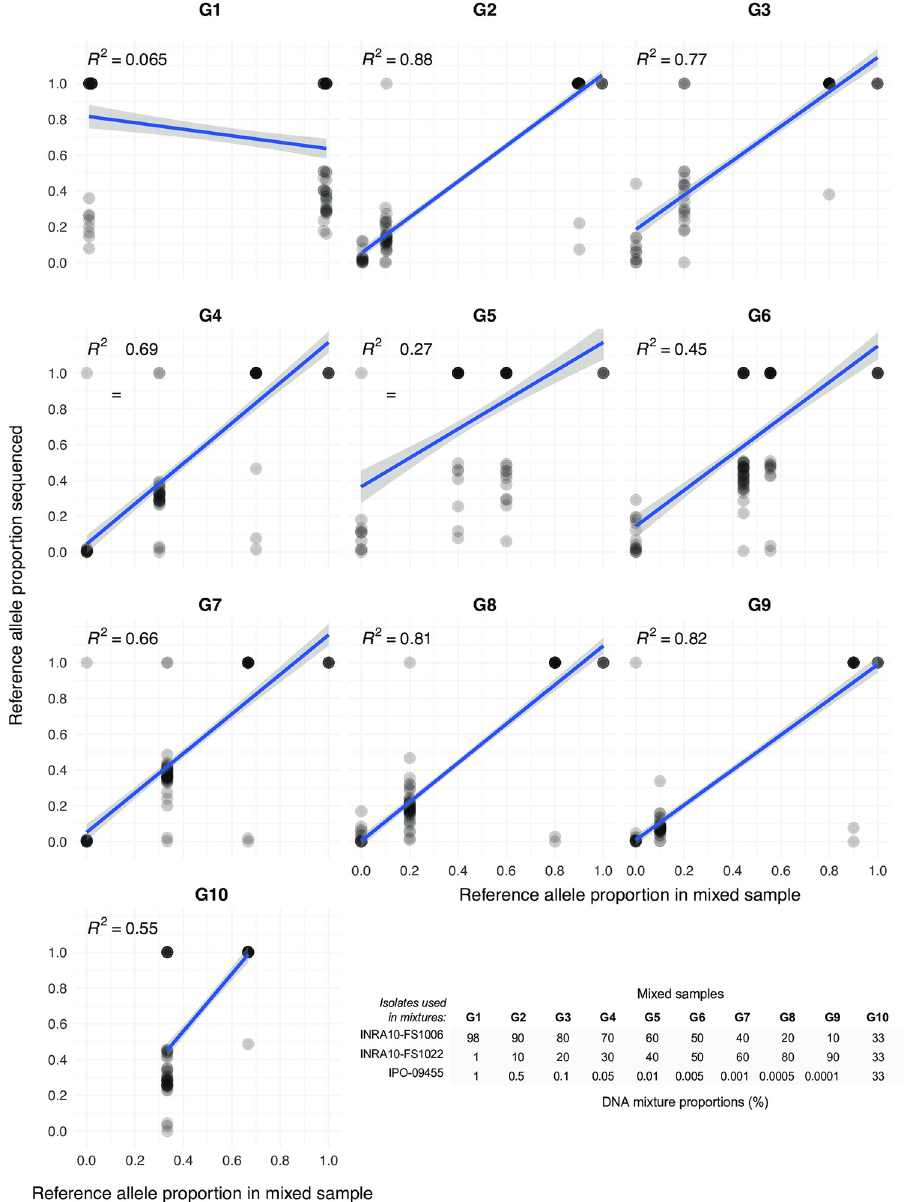
Fig 4. Evaluation of mixed sample analyses. Ten samples (G1-G10) contained mixed DNA of three different isolates (INRA10-FS1006, INRA10-FS1022, IPO-09455) varying in proportions. Genotypes of each of the isolates were retrieved from whole-genome sequencing of pure isolates and assigned as reference alleles ( i . e . matching the allele present in the reference genome IPO323) or alternative alleles. Using known genotypes of the three isolates, reference allele proportions were defined according to the dilutions in mixed samples G1-G10. Amplicon sequencing data of mixed samples was screened for all genotyped SNPs to assess the proportion of the reference allele among all mapped Illumina reads. Only SNPs with a minimum read coverage of 50 were used. Regression R 2 were calculated based on a linear model.